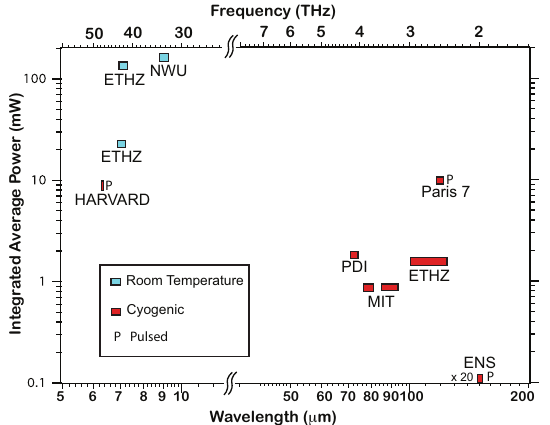
Figure 13: Average emitted power as a function of frequency cov- erage for published QCL-based comb sources. Rectangles width indicates the frequency coverage and the average power refers to the integrated laser output on all the emitted wavelengths. Data from the following groups: ETHZ [59, 69, 71], NWU [72], Paris 7 [38], PDI [73], Harvard [37], ENS [50], MIT